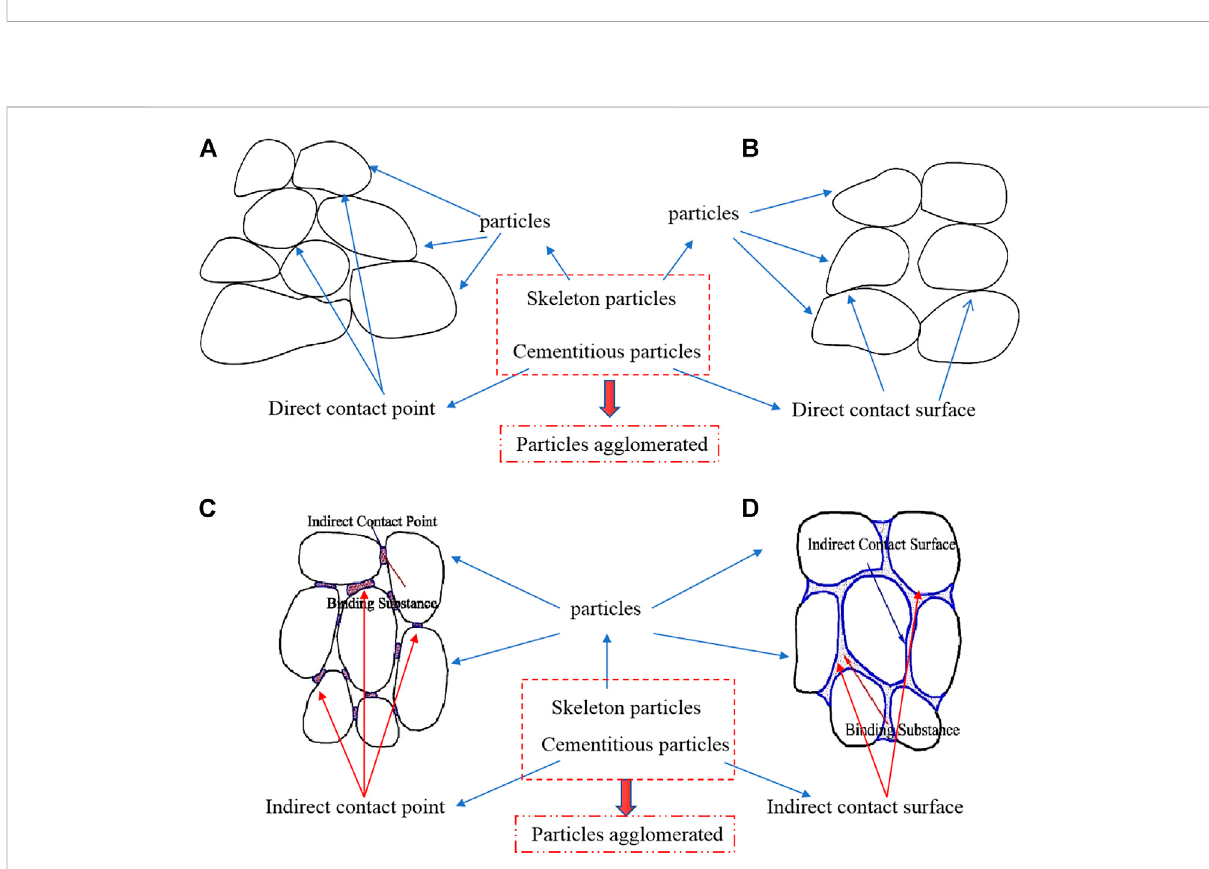
FIGURE 10 The clay agglomeration effects: (A,B) Sample 2 in disease segment, (C,D) Sample 5 in non-disease